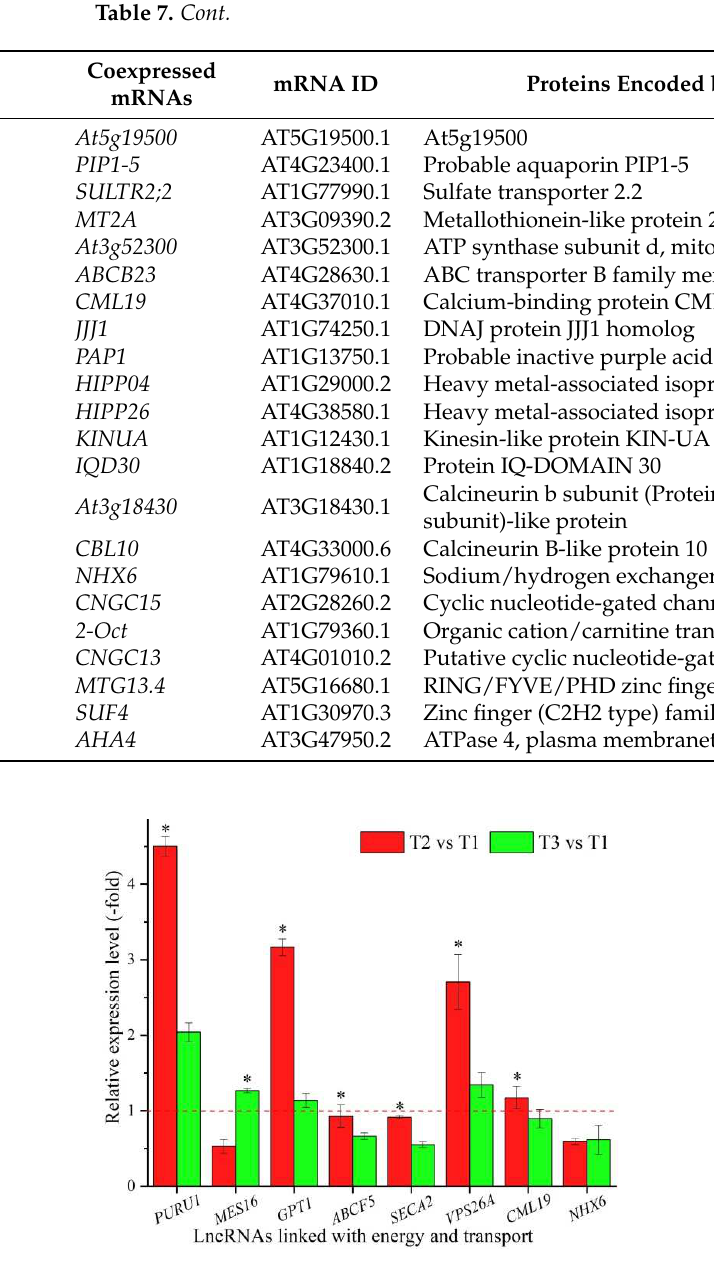
Figure 7. The expression levels of coexpressed mRNAs of lncRNAs linked with energy and transport in A. sinensis at T2 vs. T1 and T3 vs. T1, as determined by qRT-PCR. The “*” represents a significant difference at p < 0.05 level between T2 vs. T1 and T3 vs. T2 for the same